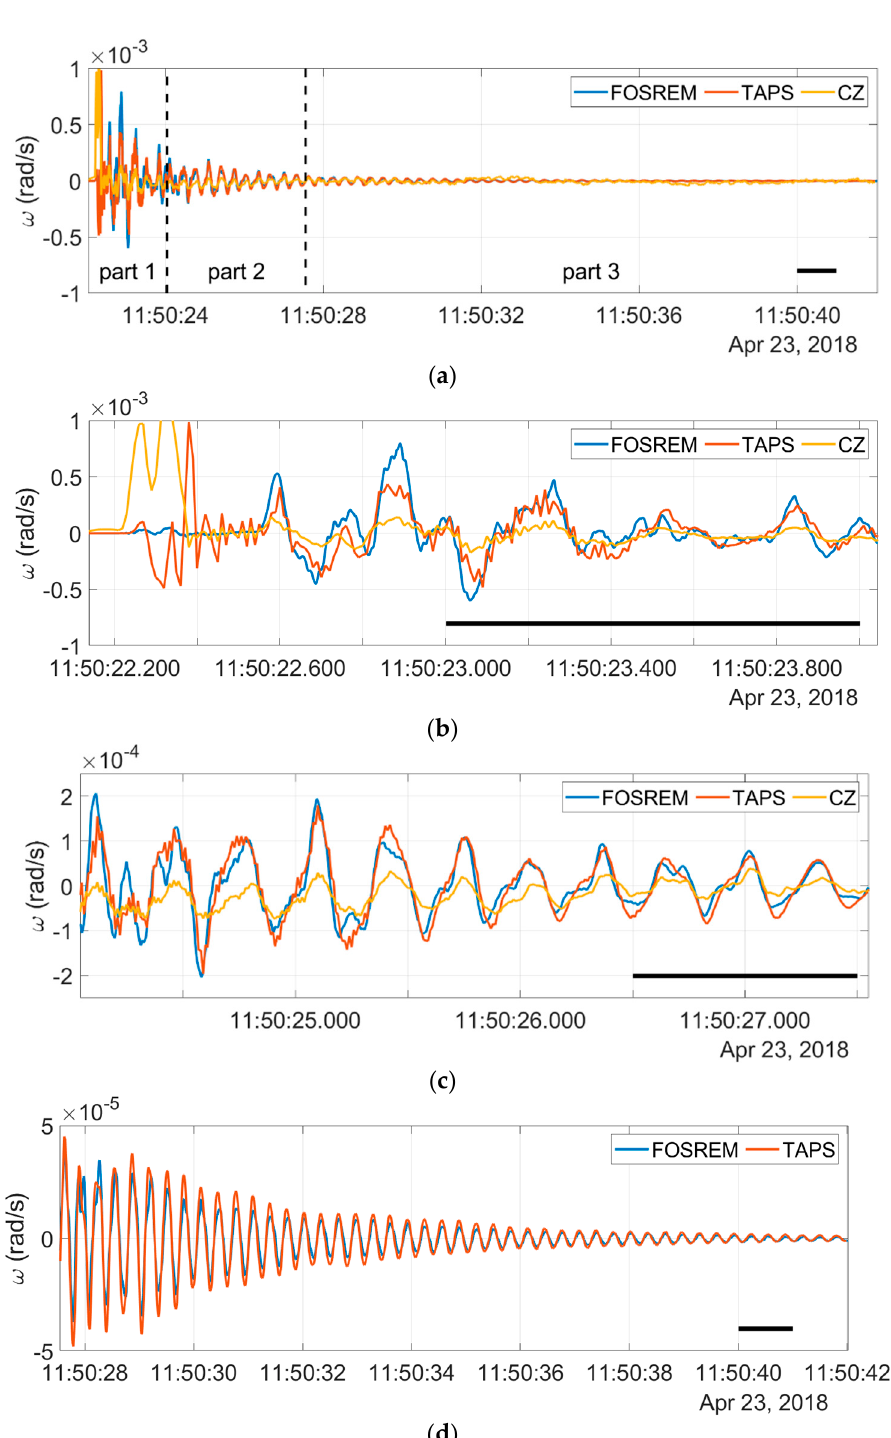
were well-matched except, for noisy data from the CZ sensor (Figure 5d).